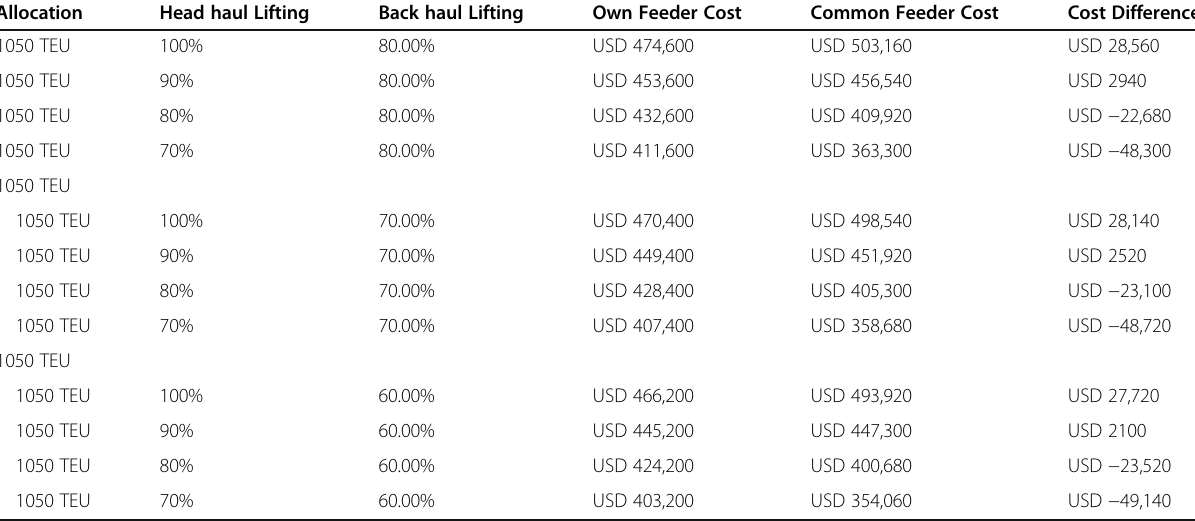
Table 3 Cost Comparison between Own Feeder Service and Common Feeder service under Different Allocation Lifting. (Source: authors)